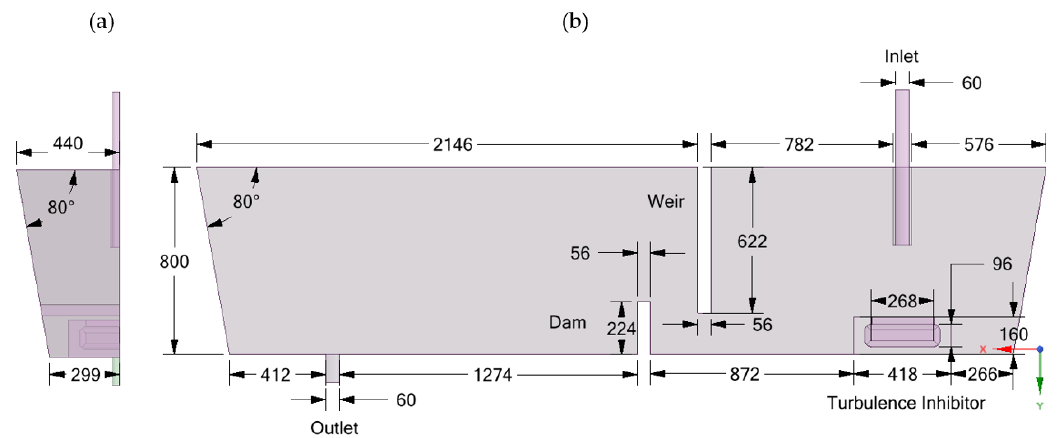
Figure 1. Dimensions of a single-strand tundish with flow control devices (dam, weir and turbulence inhibitor); ( a ) side view and ( b ) front view (unit: mm).